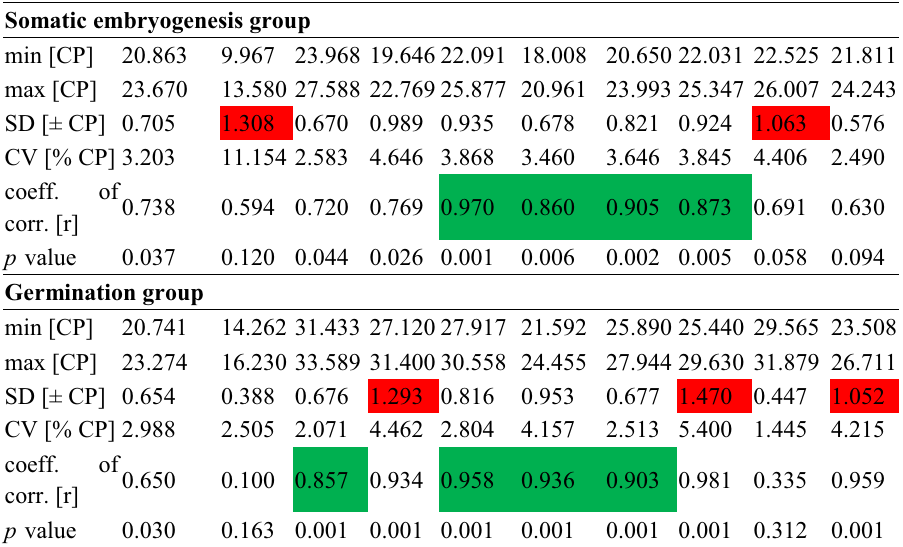
BestKeeper analysis. The results of BestKeeper analysis are shown in Table 2. For the embryogenesis group, 18S rRNA and TUB were eliminated because of their high standard deviation (SD) values of 1.308 and 1.063, respectively, and coefficient of variance values of 11.154 and 4.406, respectively. EF1g was the most stable gene, with the highest correlation coefficient (r) value (0.970, p ˂ 0.01). This was followed by HIS1 (r = 0.905, p ˂ 0.01), TUA (r = 0.873, p ˂ 0.01) and GAPDH (r = 0.860, p ˂ 0.01). These genes were also the four most stable genes